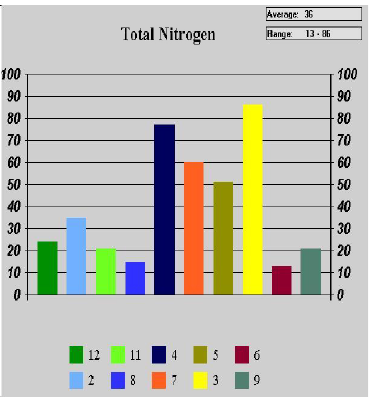
FIGURE 9. Nitrate N levels from each zone in Fig. 8 (kg/ha; 0- to 61-cm sampling depth).